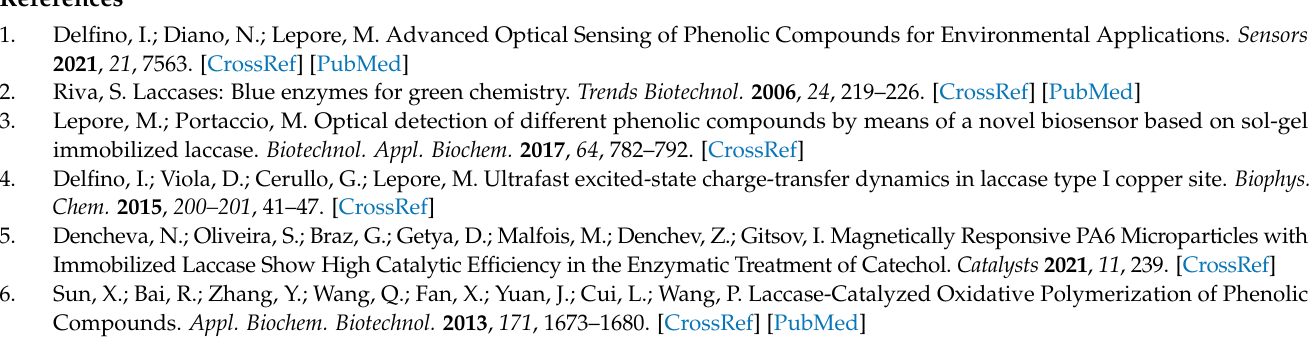
Figure 4. Time course behaviour of emission values at a fixed wavelength (360 nm). Measurements were performed at various times: immediately after catechol addition, 5 min, 10 min, 50 min and 80 min after catechol addition.